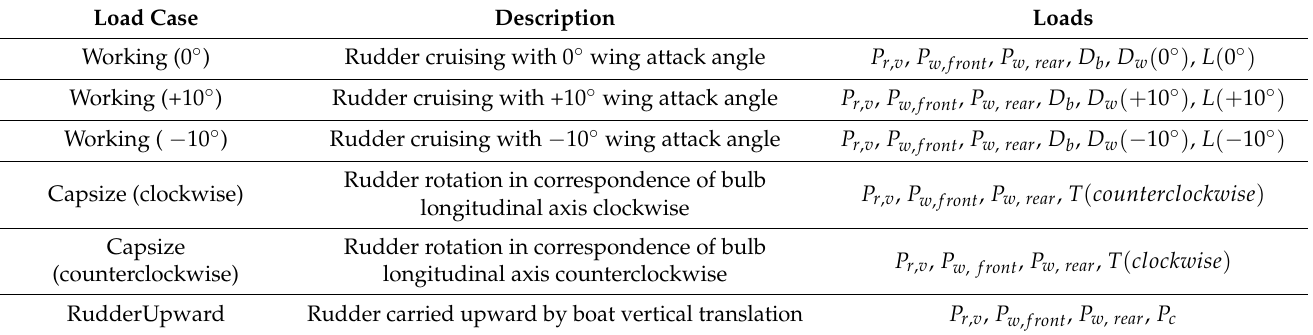
Table A1. Considered load cases.